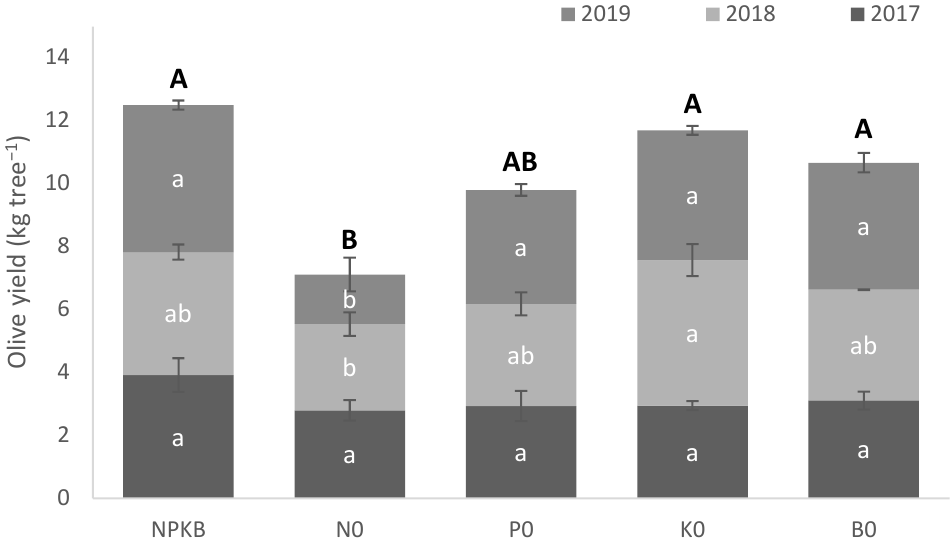
Figure 1. Olive yield from trees supplied with NPKB (control) and without N (N0), P (P0), K (K0) and B (B0) in 2017, 2018 and 2019. Vertical bars represent the standard errors. Within each year (lower case letters) and accumulated total (upper case letters), means followed by the same letter are not significantly different by Tukey’s HSD test (α = 0.05).